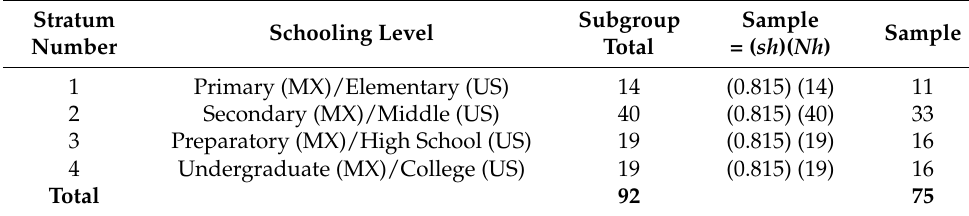
Table 2. Stratified probability sampling.